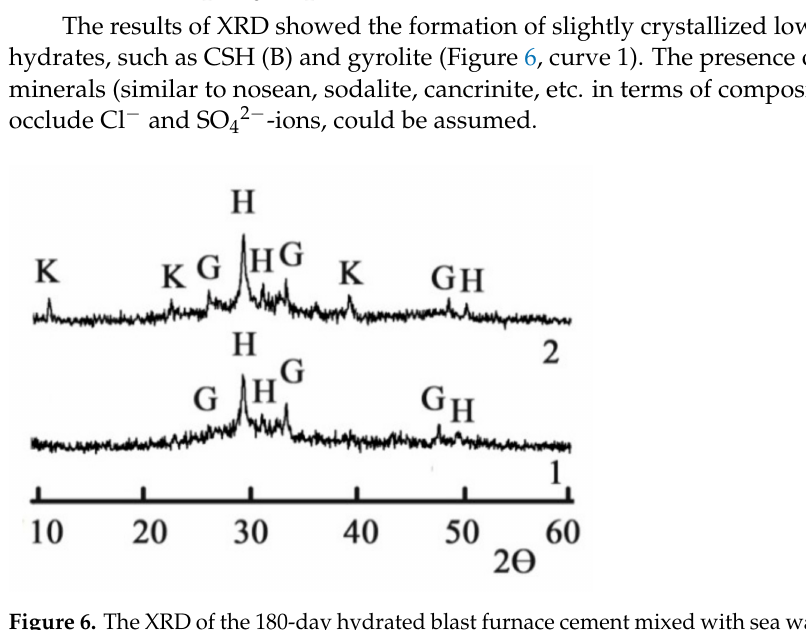
Figure 6. The XRD of the 180-day hydrated blast furnace cement mixed with sea water and